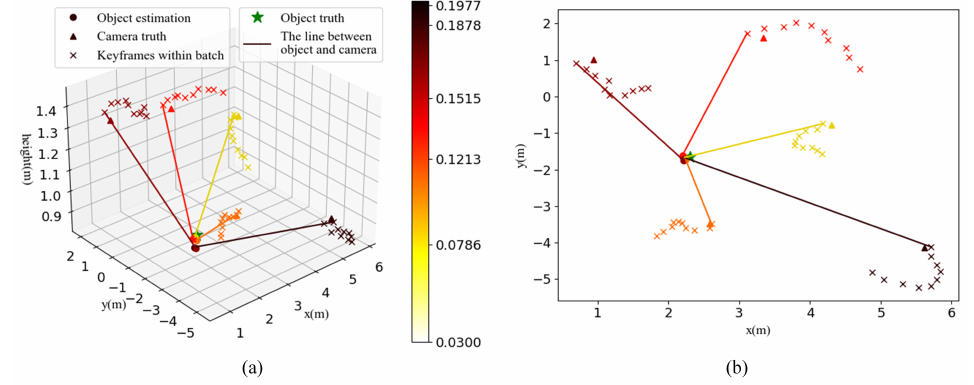
Figure 11. Multiple view object positioning evaluation. ( a ) Three-dimensional view. ( b ) Over- head view.